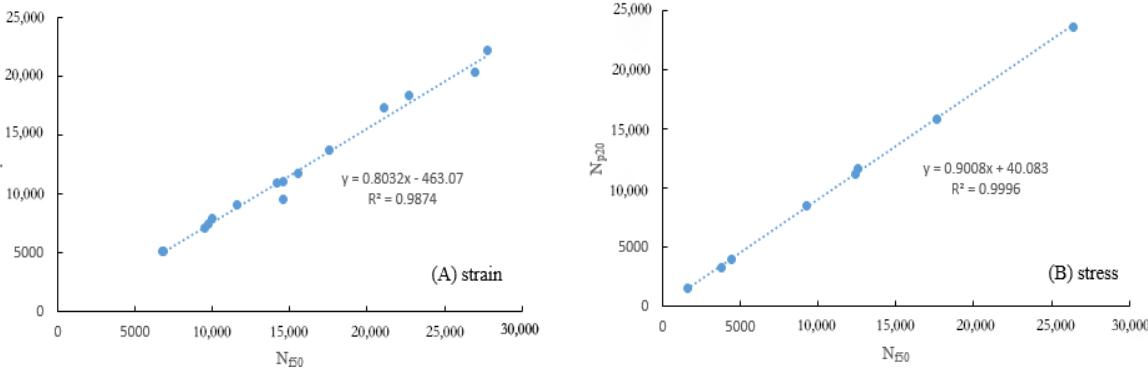
Figure 9. Correlation between N p20 and N f50 under strain/stress ‐ control.